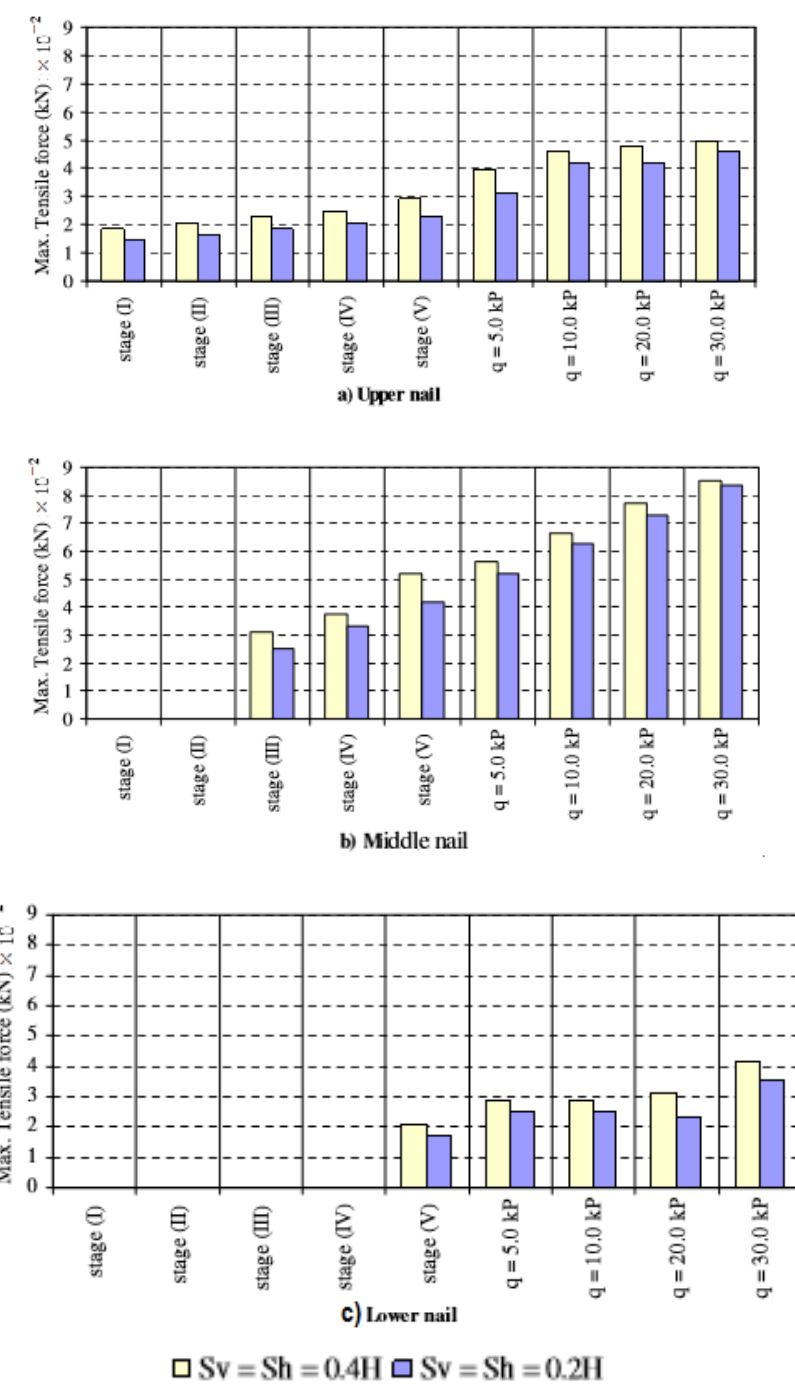
Figure 24. Influence of nail spacing on the maximum tensile force of the